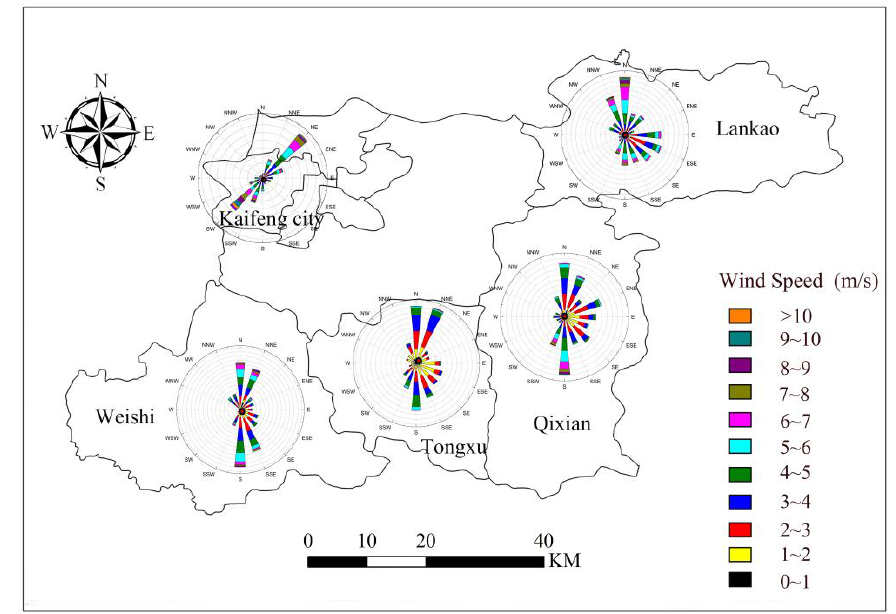
Figure 9 . The dominant wind direction in summer (June, July, and August). Figure 9. The dominant wind direction in summer (June, July, and August). According to the dominant wind direction in Kaifeng, it is shown that the air flow from the Yellow River and the outer suburbs can blow into the city and help reduce the temperature inside the city and possibly alleviate the urban heat island effect. Therefore, on the basis of analyzing the land surface temperature, action space, underlying surface influential factors, and dominant wind direction in Kaifeng, air duct openings were selected in the Yellow River, Kaifeng Yintan, Baogong Lake, and Longting Lake, and under the action of the dominant wind direction, airflow can blow into the city through the